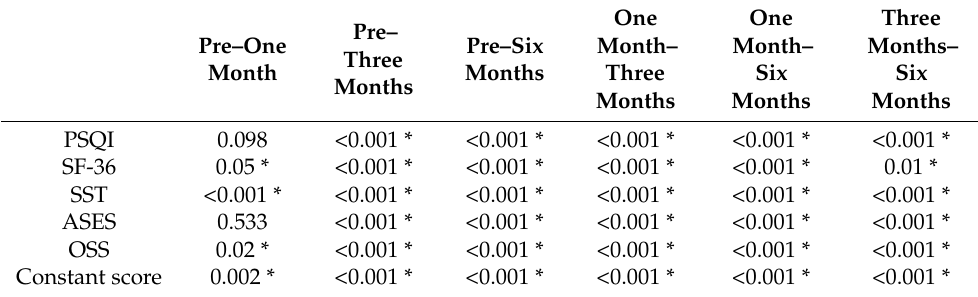
Table 2. Score differences in the follow-up periods. Note: * = statistically